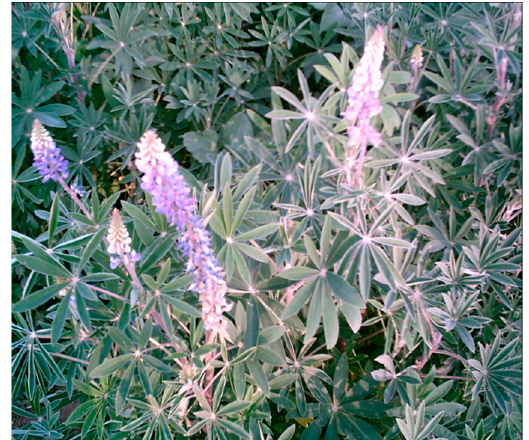
Figure 7. Lupinus exaltatus Zucc. Photo: M. Ruiz.